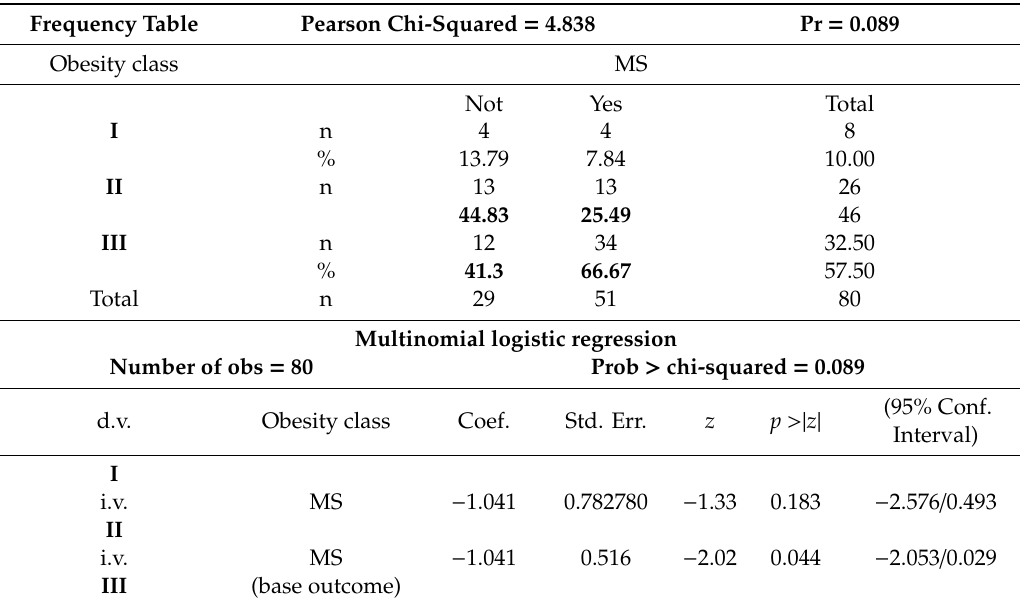
Legend to Table 2: MS, metabolic syndrome. The results of the multinomial logistic regression agree with the column percentages presented by tabulate being the multinomial logistic regression model saturated. Sub-analysing, both models test that the column percentages of obesity classes II are inversely related to the others, regards to the presence of MS, i.e., there were more patients without than with MS, confronted with class III, specified as base outcome; d.v., dependent variable; i.v., independent